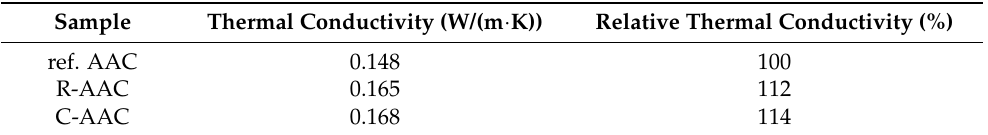
Table 5. Thermal conductivity of AAC samples.